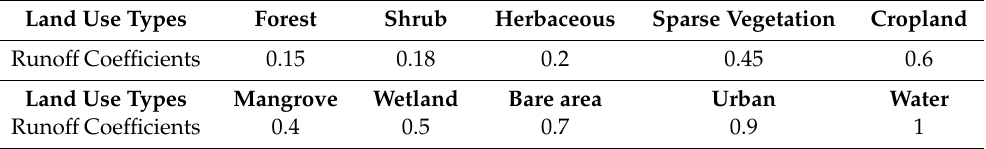
Table 2. Land use types and corresponding coe ffi cients.